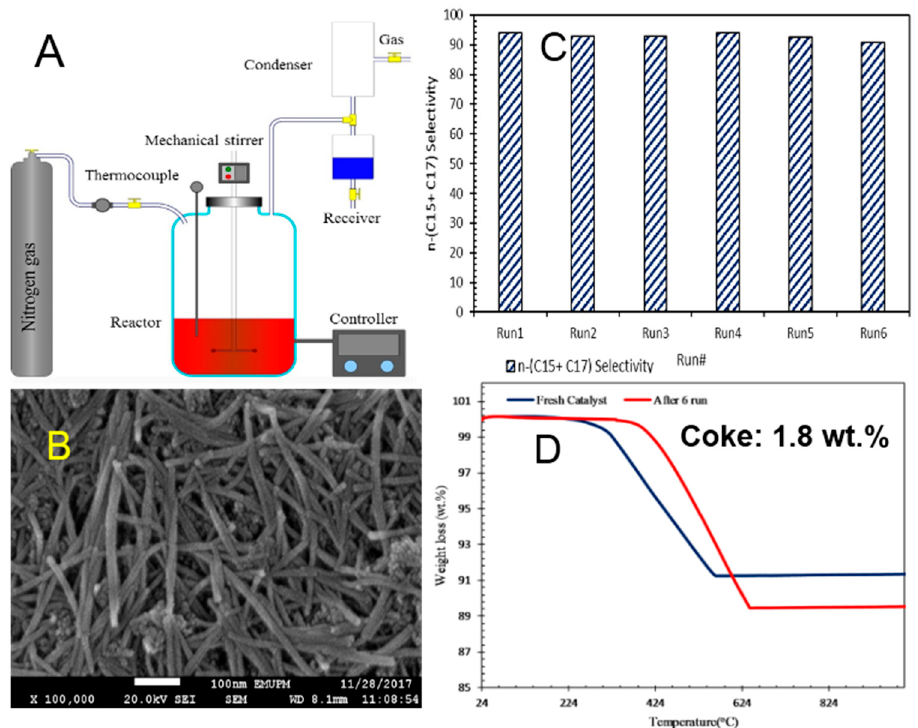
Figure 4. ( A ) Schematic diagram for the DO set-up, ( B ) FESEM image for Ag 2 O 3 –La 2 O 3 / AC nano , ( C ) n-(C 15 +C 17 ) selectivity with the number of DO cycles at temperature of 350 °C, catalyst amount of 1 wt % and reaction time of 120 min under inert condition, and ( D ) thermogravimetric analysis (TGA) profile for fresh and spent Ag 2 O (10%) -La 2 O 3(20%) /AC nano catalyst after six runs [98].